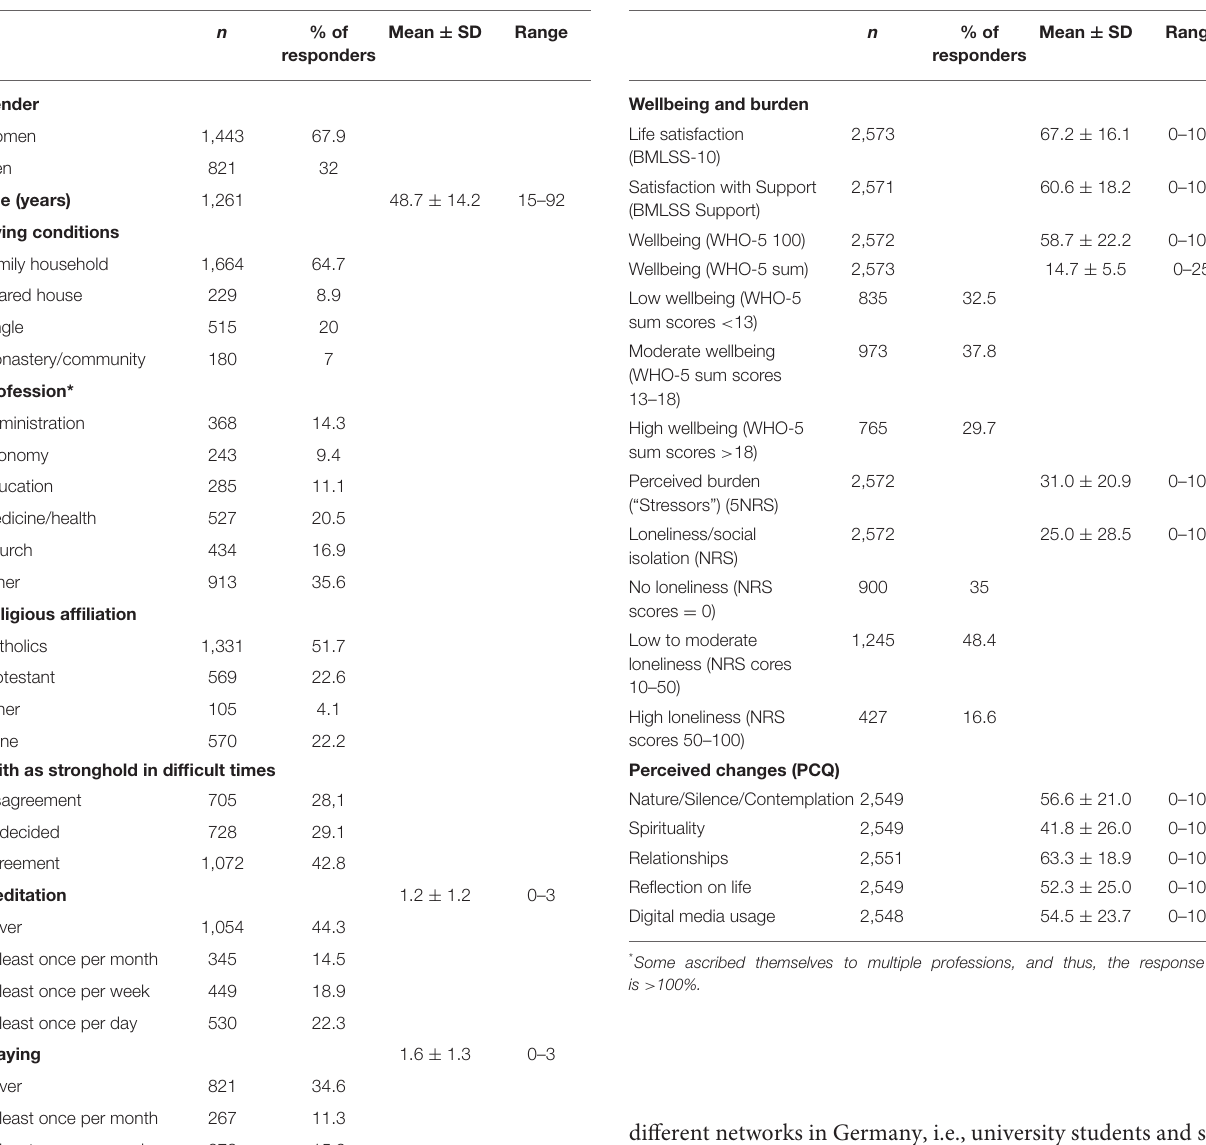
TABLE 1 | Sociodemographic data of participants ( N =